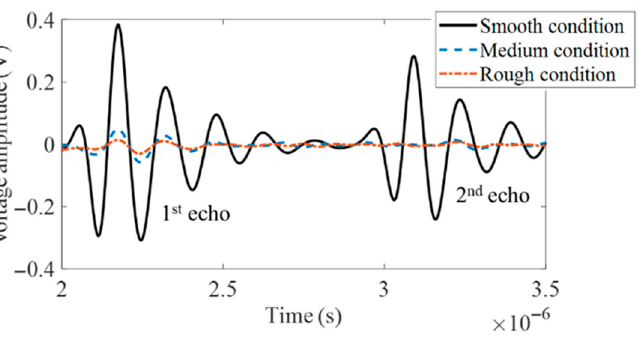
Figure 9. Ultrasonic 1st and 2nd echo signals measured from surfaces with the “smooth condition”, “medium condition”, and “rough condition”.